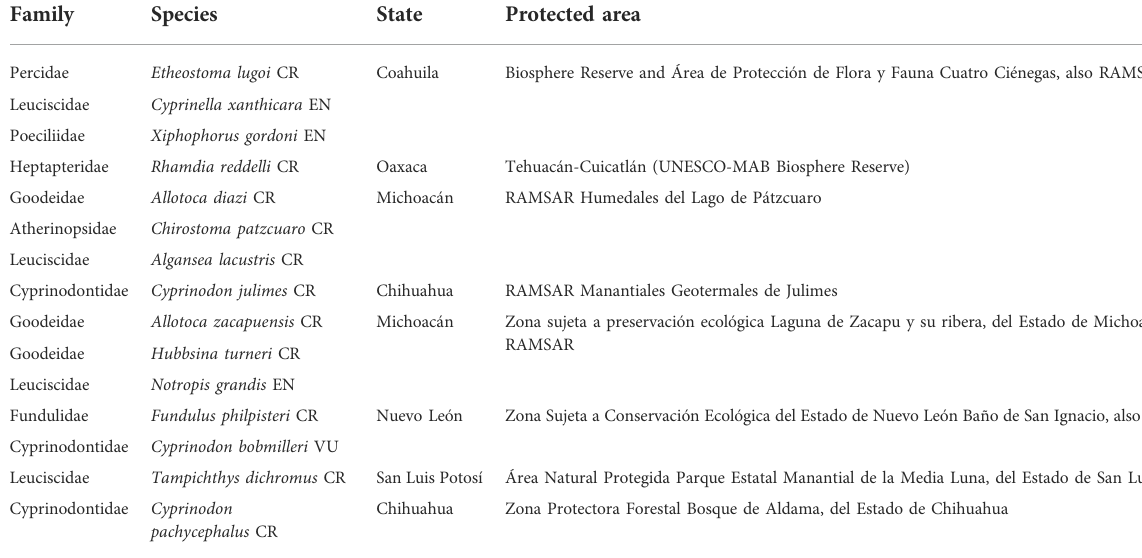
TABLE 2 List of CR + species found in protected